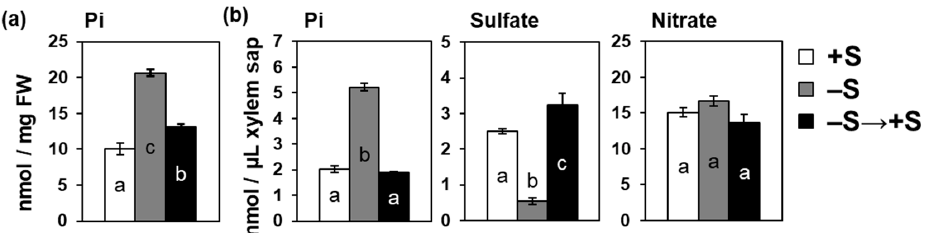
Figure 5. Resupplying of sulfate reversed the effects of –S on Pi accumulation in shoots ( a ) and xylem sap ( b ). Twenty-day-old plants were transferred to hydroponic media supplemented with 1500 µ M sulfate (+S) for 3 days before starting the treatment. For treatments, plants were divided into three sets; + S (white bar), kept under + S for additional 3 days; –S (gray bar), transferred to hydroponic media without sulfate (–S) and kept for 3 days and –S → +S (black bar), transferred to –S media, kept for 2 days, and transferred to +S media for additional 1 day. All plants were harvested on the same day. Bars and error bars indicate mean ± SE ( n = 4). Different letters indicate significant difference detected by the Tukey–Kramer test (* p < 0.05).